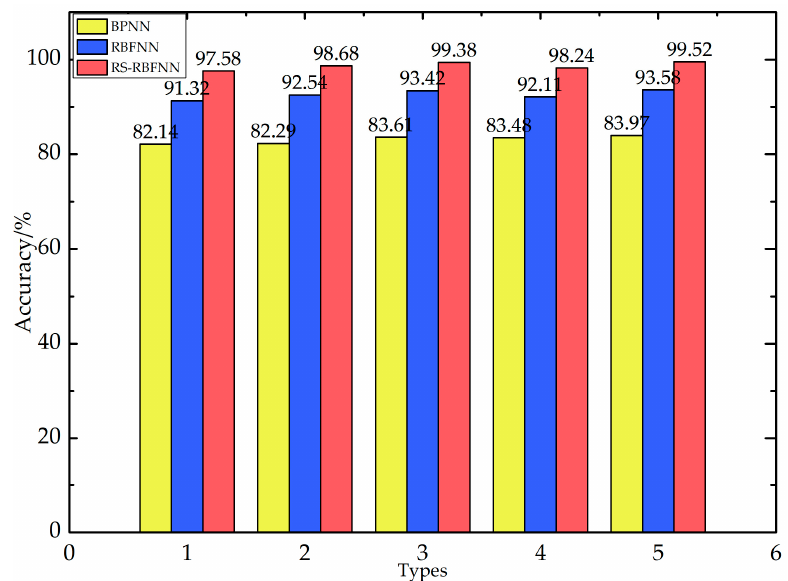
Figure 11. The accuracy comparison of the three fault diagnosis methods.